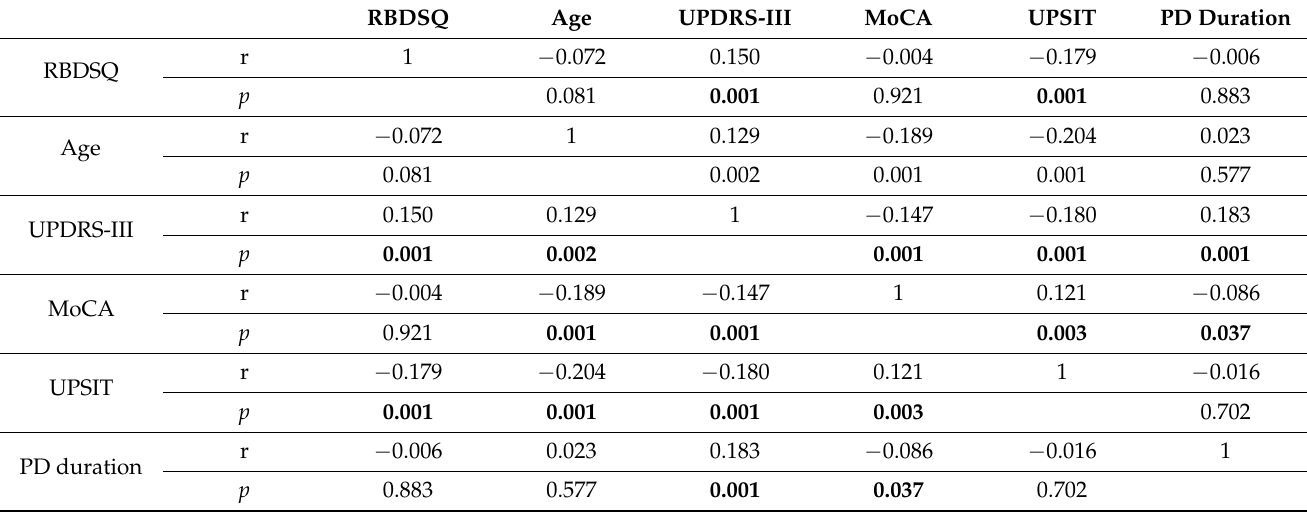
Table 2. Correlations among demographic data, clinical, motor, and non-motor assessments in patients affected by Parkinson’s disease. RBDSQ Age